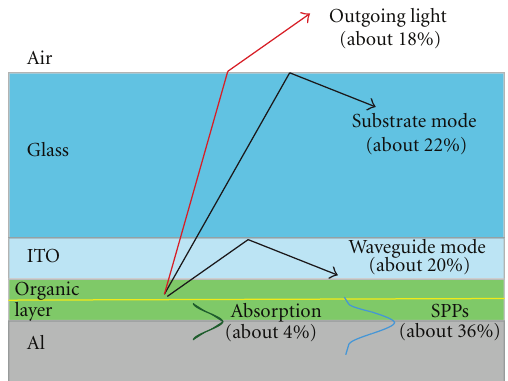
Figure 1: Kinds of light out-coupling losses in ordinary